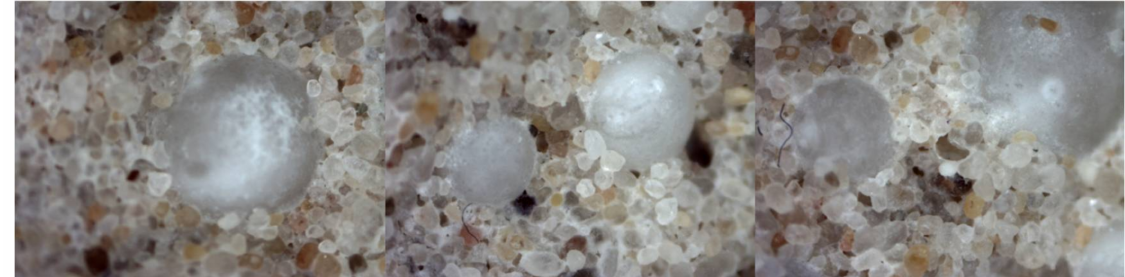
Figure 20. Embedding of solidified phase change proppant on the surface of rock slab.